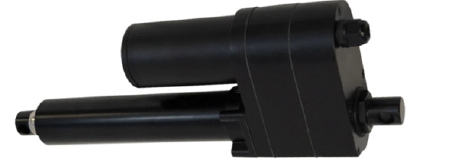
Figure 13. Progressive Automations PA-17 electric actuator [22]